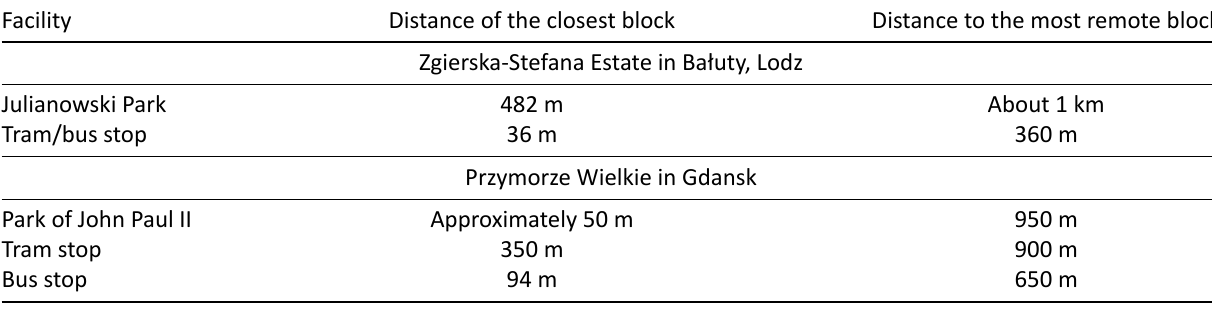
Table 4. Distances to the closest facilities:Park and stops for public